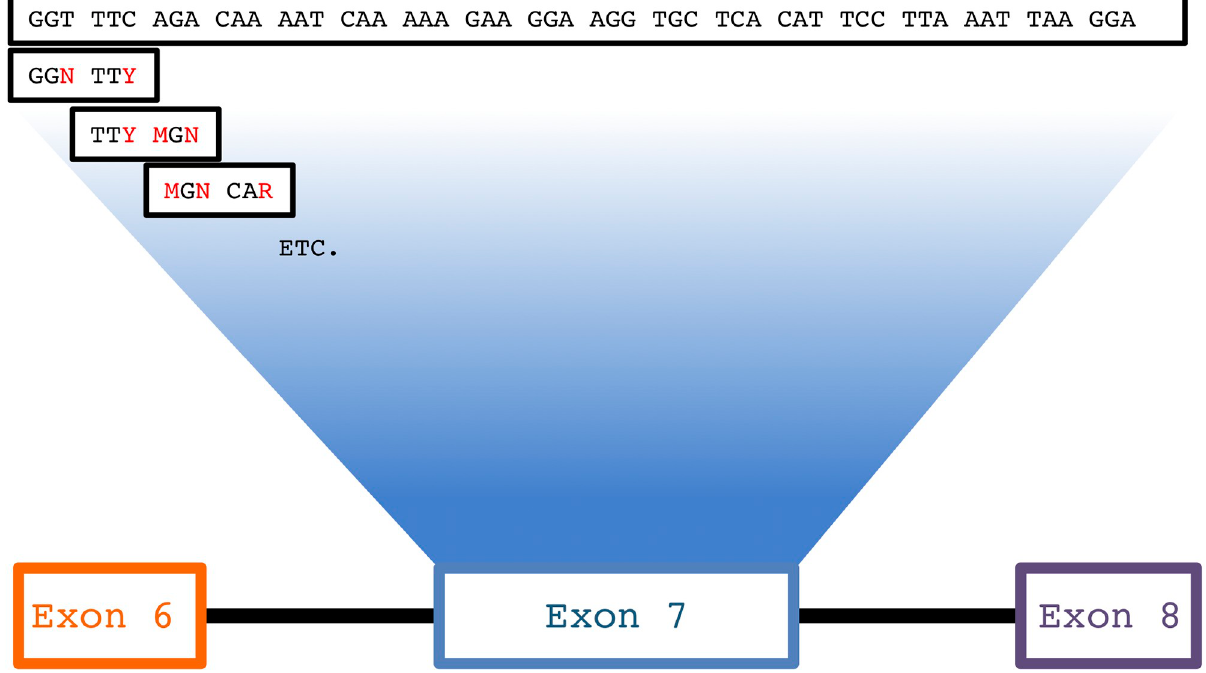
Fig 1. Mutation scheme for SMN1 exon 7 library. The SMN1 mini-gene construct consists of exon 6, exon 7, and exon 8 with shortened introns 6 and 7. All possible silent mutations in exon 7 were created within the context of a sliding hexamer window. For example, the first two codons depicted are GGT TTC. All three mutations were made in GGT resulting in GGN and combined with all silent mutations in TTC (TTT), resulting in eight combinations including the wild-type sequence. A transition 6C ! T results in SMN1 exon 7 skipping.